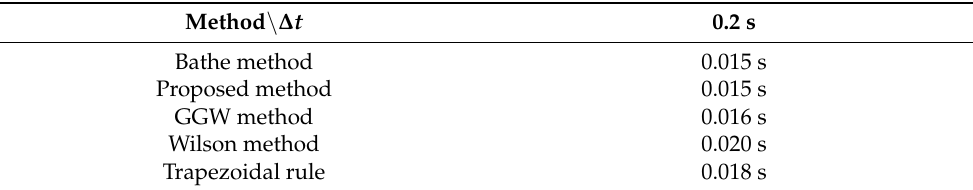
Figure 7. Acceleration responses with the Wilson method, Bathe method, GGW method, trapezoidal rule, and the proposed method from 40 to 50 s. Table 1. Computational time of different methods for Problem 4.1.